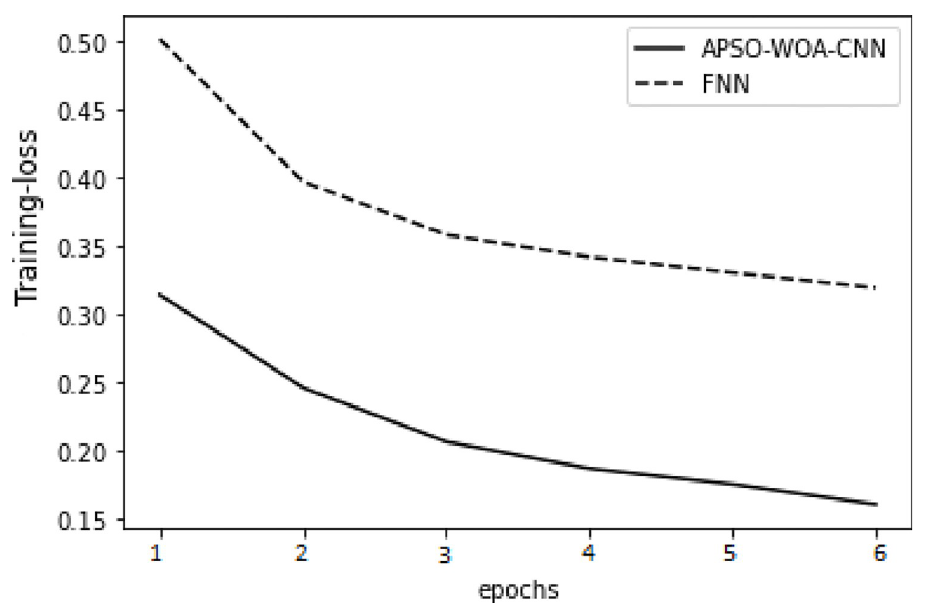
Fig 6. APSO–WOA–CNN and FNN algorithms’ loss function training sets.